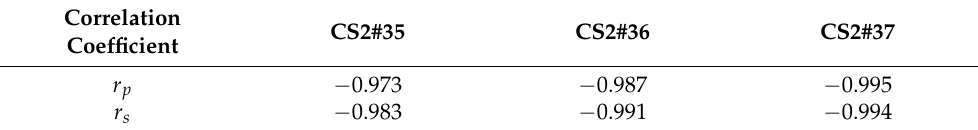
Table 1. Statistical table of correlation